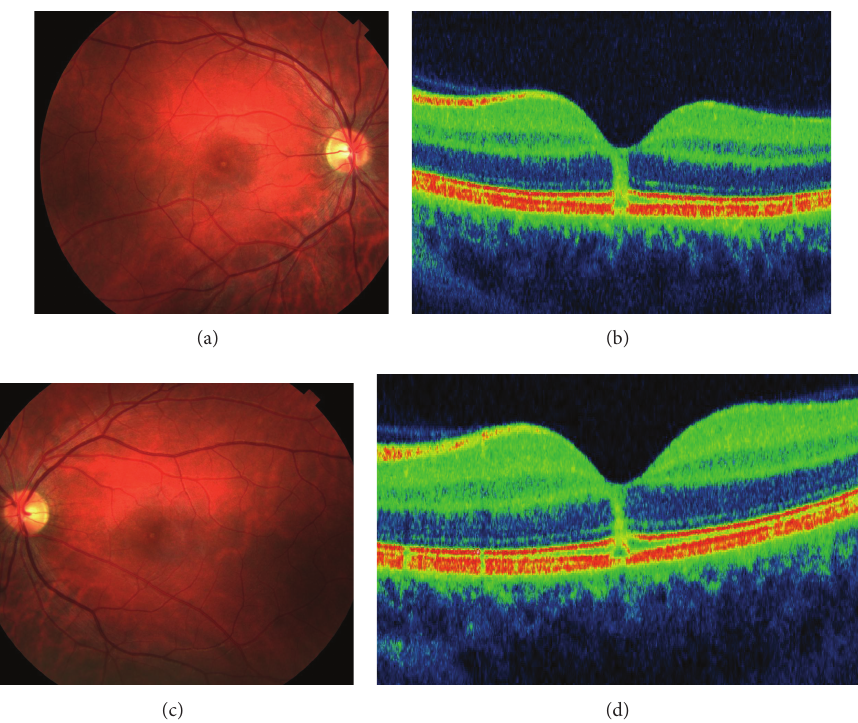
Figure 2: The color fundus of the right and left eyes showed a reduced foveal reflex (a, c). SD-OCT detected increased foveal rod-shaped full-thickness hyperreflectivity that extended from the outer segments of the photoreceptors and the RPE to the inner layer of the retina and interruption of the external limiting membrane and of the IS/OS junction, bilaterally (b,